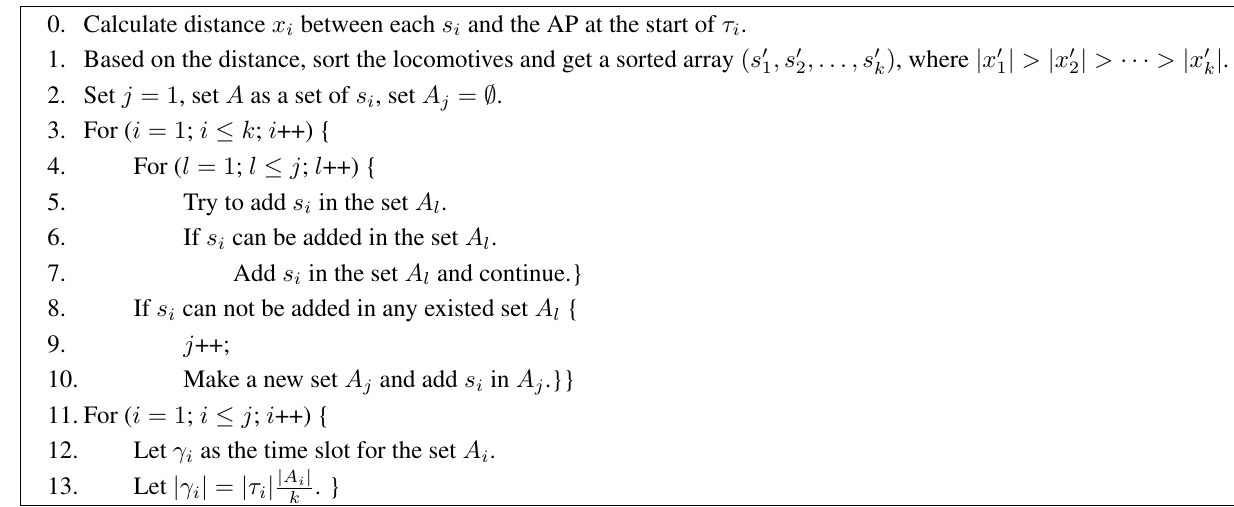
Figure 4. The arranging time slots algorithm for each